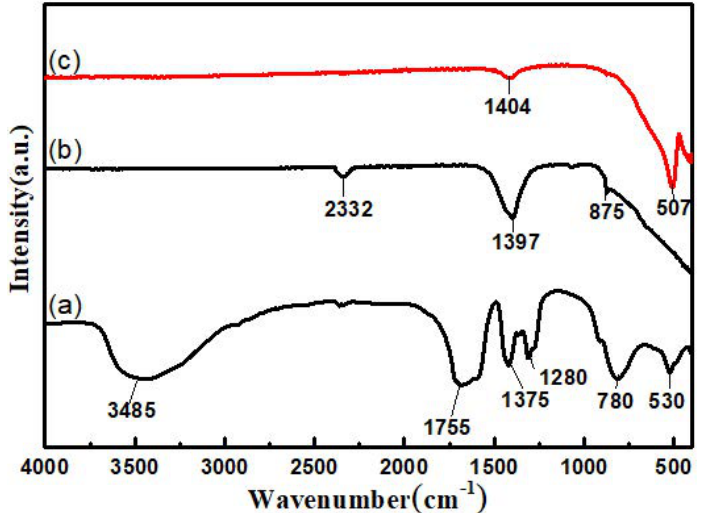
Figure 2. The FT-IR spectra of BST precursors ( a ) dried at 100 ◦ C and calcined at ( b ) 500 ◦ C and ( c ) 800 ◦ C,